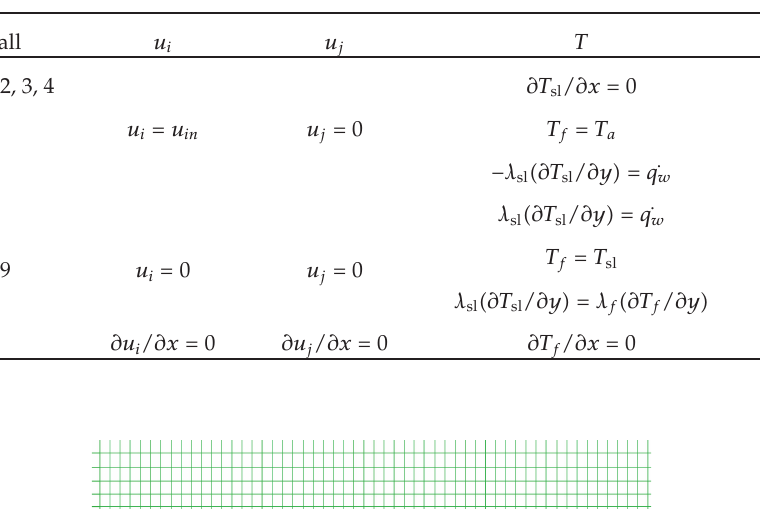
Table 3: Boundary conditions.